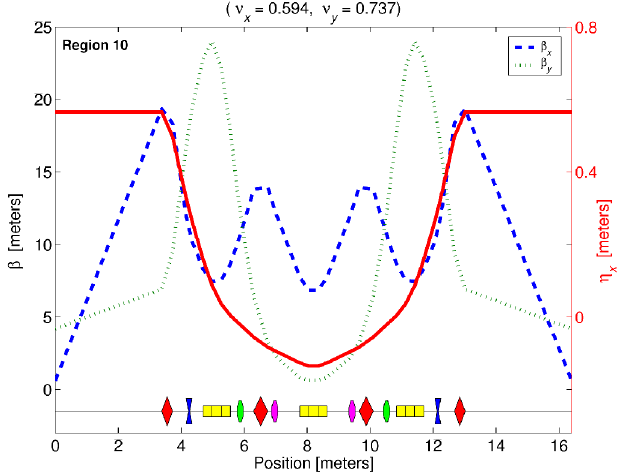
FIG. 9. (Color) Lattice of one of 12 ALS TBA sectors and associated lattice functions in region 10.